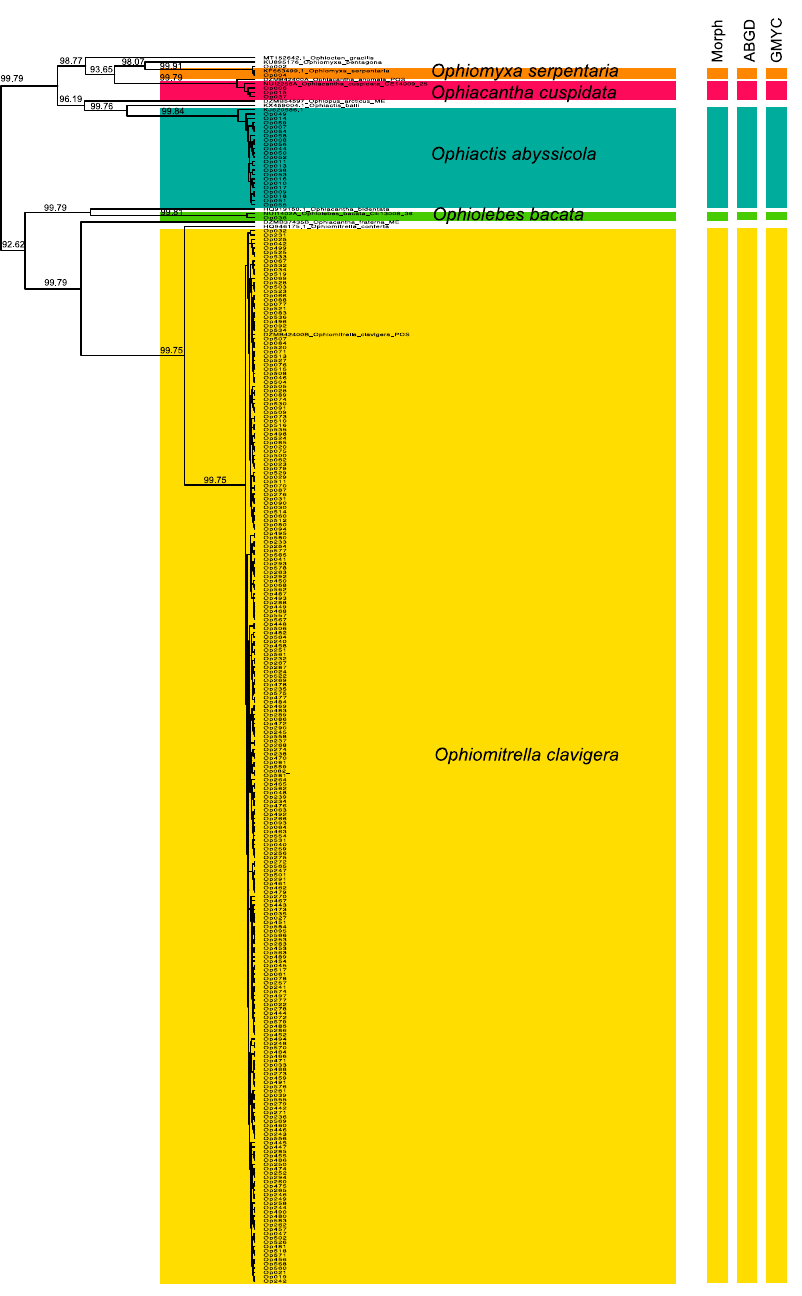
Figure 3. Gene tree of Bayesian analysis of COI (numbers on branches represent posterior probabilities >0.92) and species delimitation tools for COI fragment. The vertical bars represent alternative taxonomies, respectively supported by Automatic Barcoding Gap Discovery (ABGD) and General Mixed Yule Coalescent (GMYC), in addition to morphology. The colors are related to the identified clades.